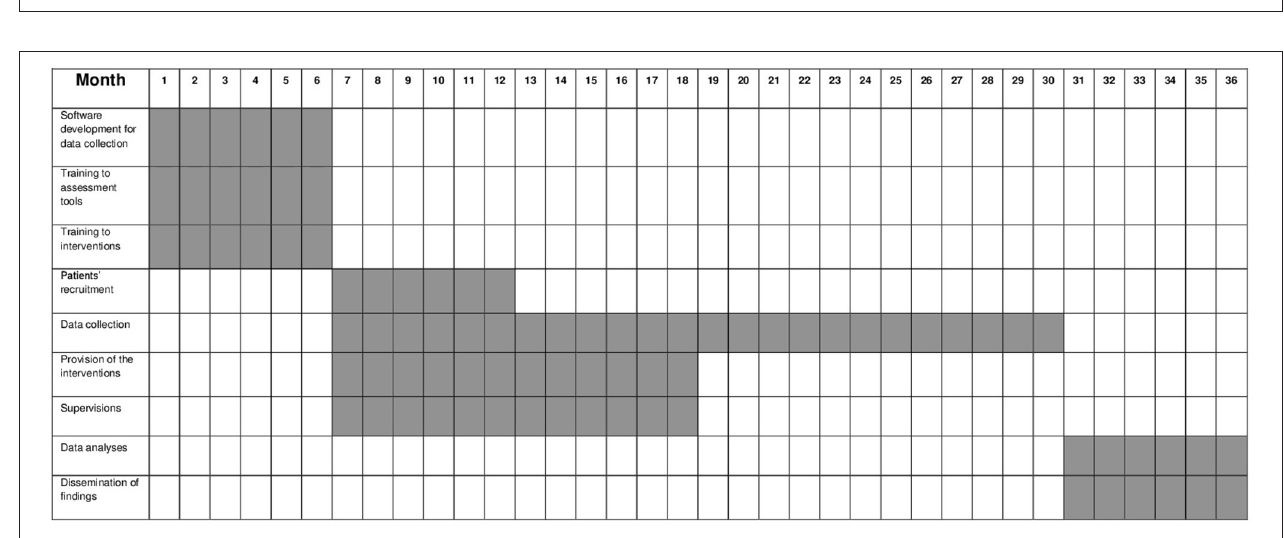
FIGURE 1 | Power analysis and sample size.